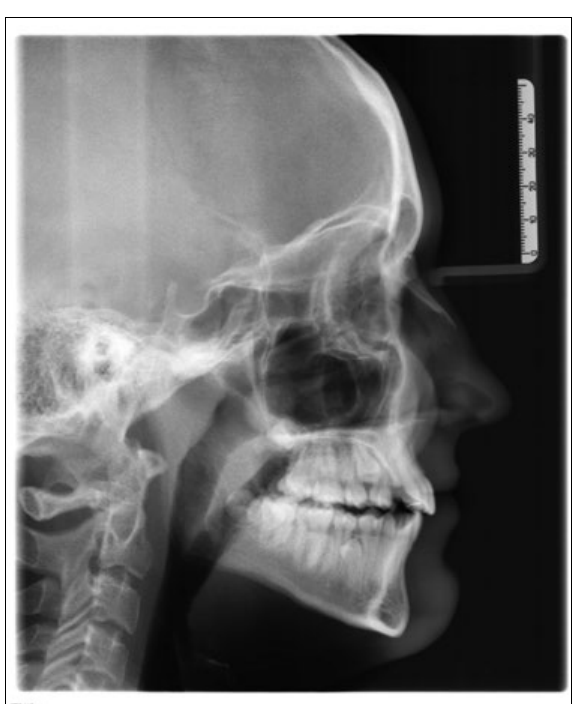
Figure 2. Lateral cephalogram at the age of